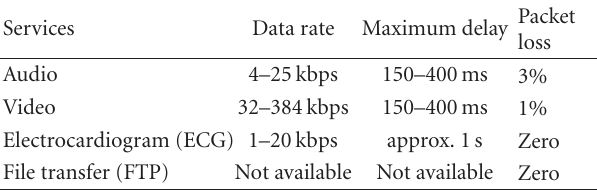
Table 3: QoS requirements for medical data transfer